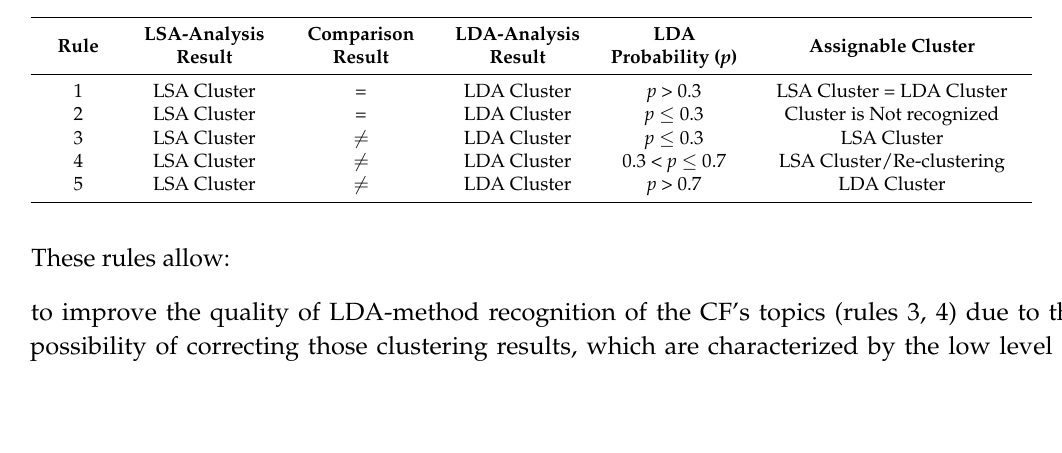
Table 9. Rules of Adjustments of CF Clustering